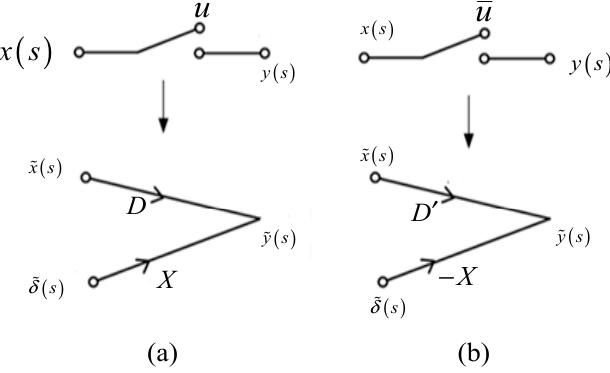
Figure 2. Small-signal switching flow graph for the switch ( a ), and the diode ( b ).